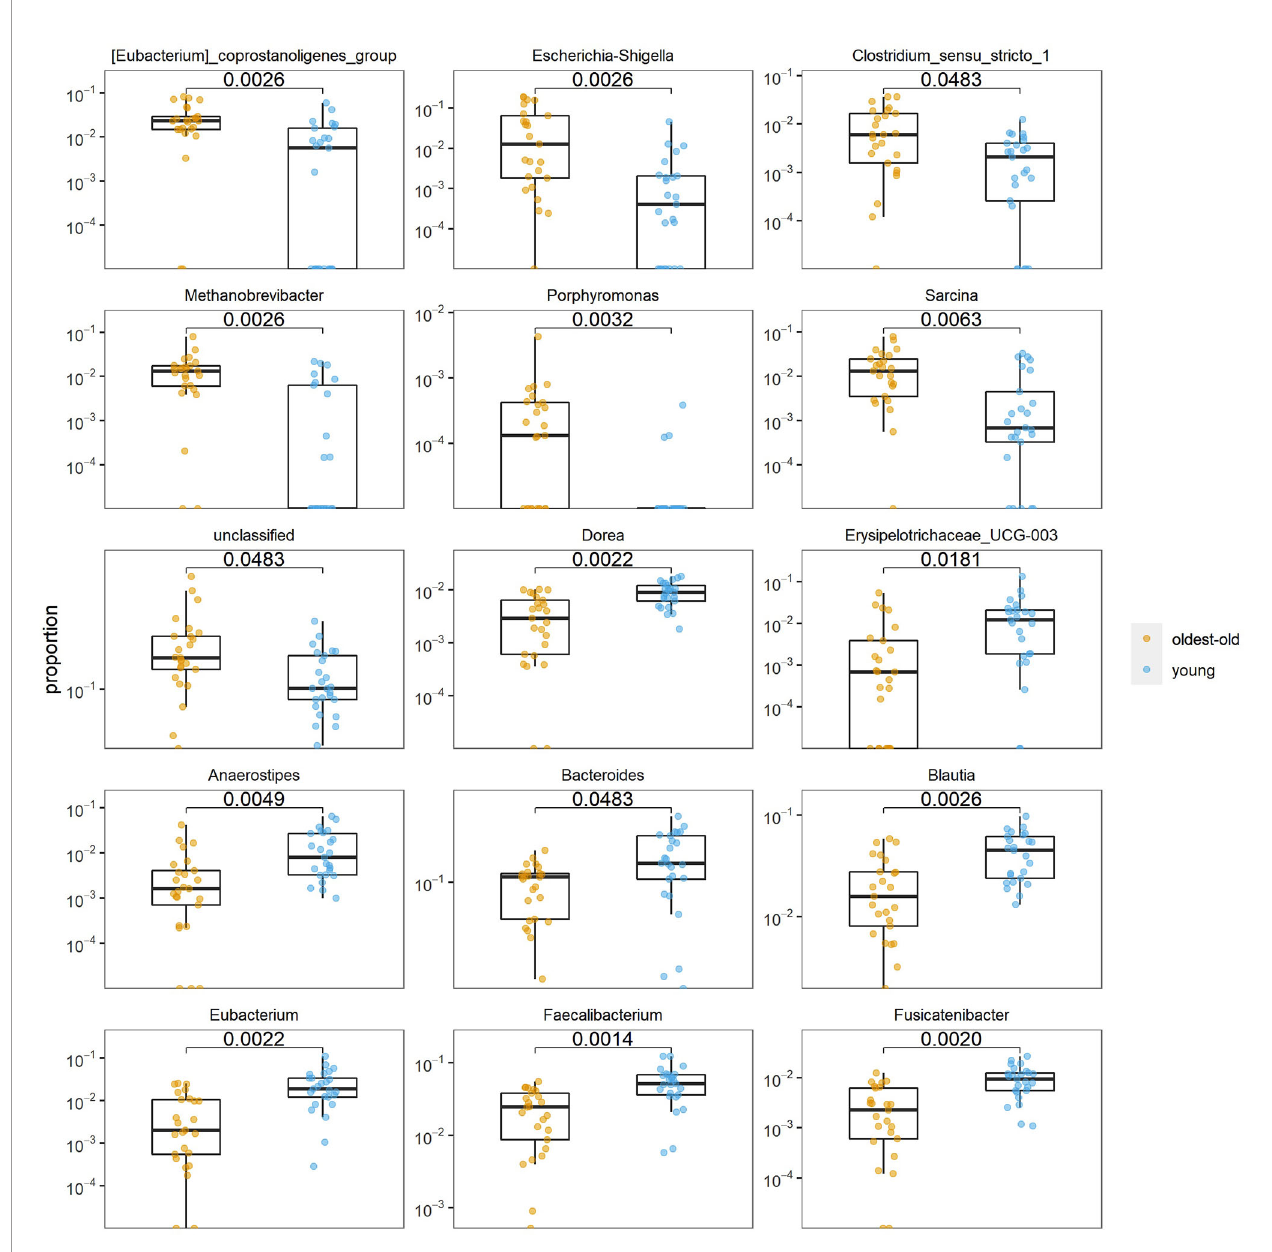
FIGURE 4 | Differences at the genus level of the intestinal microbiota in the oldest-old and young